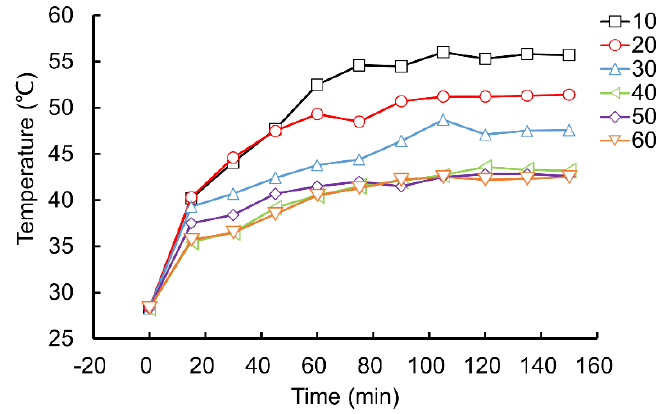
Figure 12. Effect of Preload Torque of Ultrasonic Horn on Temperature of Acoustic Vibration Component.